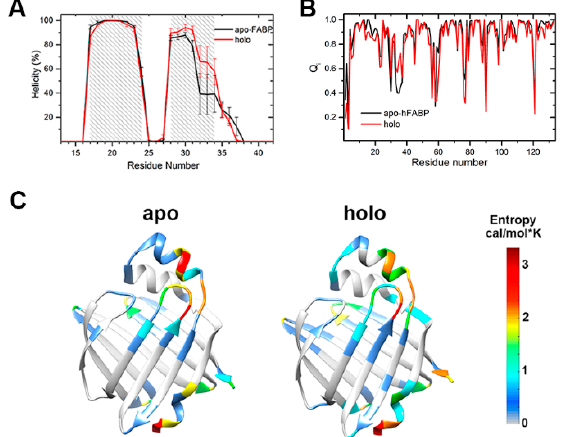
Figure 2. Structural properties of hFABP: ( A ) The helicity of the α 1 and α 2 helices; the error bars represent the mean square error in di ff erent trajectories. ( B ) The fraction of residue native contacts. ( C ) The backbone conformational entropy of each residue. A color map of the entropies is also given. The residues colored in red have large conformational entropies, and blue colors correspond to small entropies. The residues with entropy equal to 0 are colored in